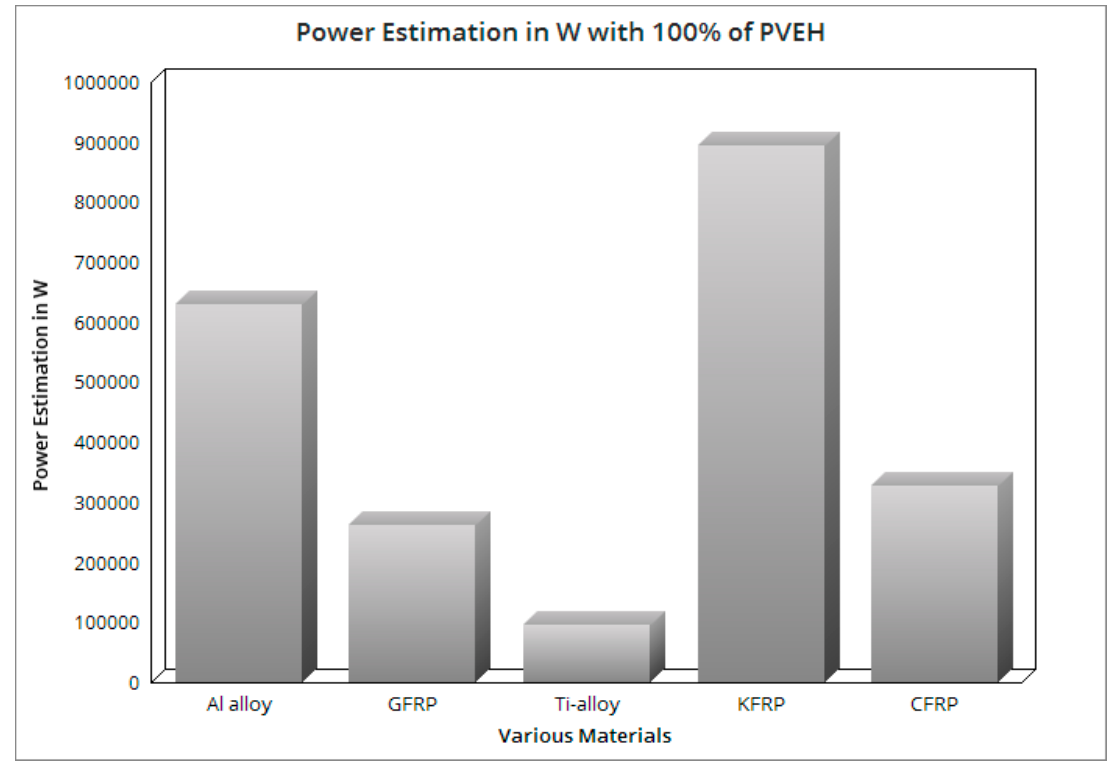
Figure 35. Power (P 0 ) in W with 100% attachment coverage—wind turbine blade.